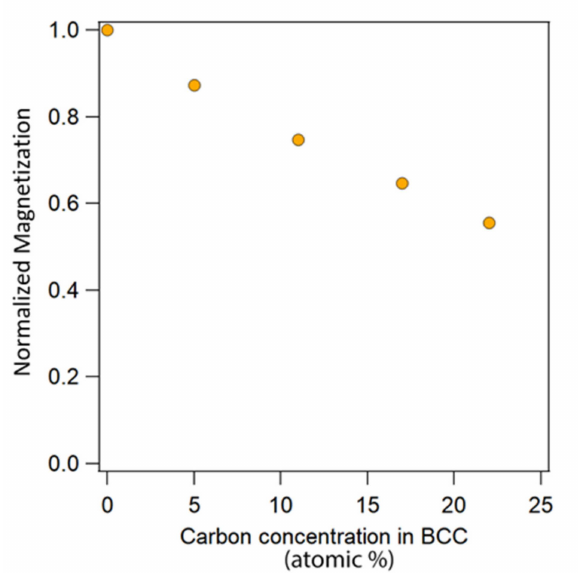
Figure 11. The normalized magnetization of BCC iron with interstitial carbon.